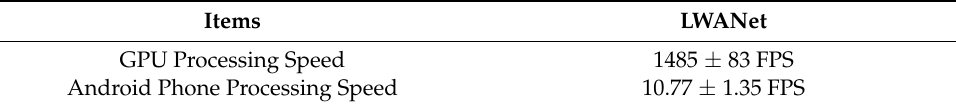
Figure 11. Schematic of an Android App development. Table 4. Real-time performance evaluation.